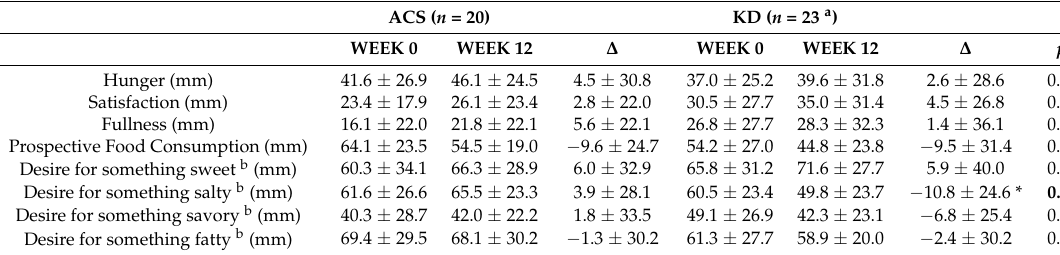
Table 2. Baseline and 12-week VAS responses by